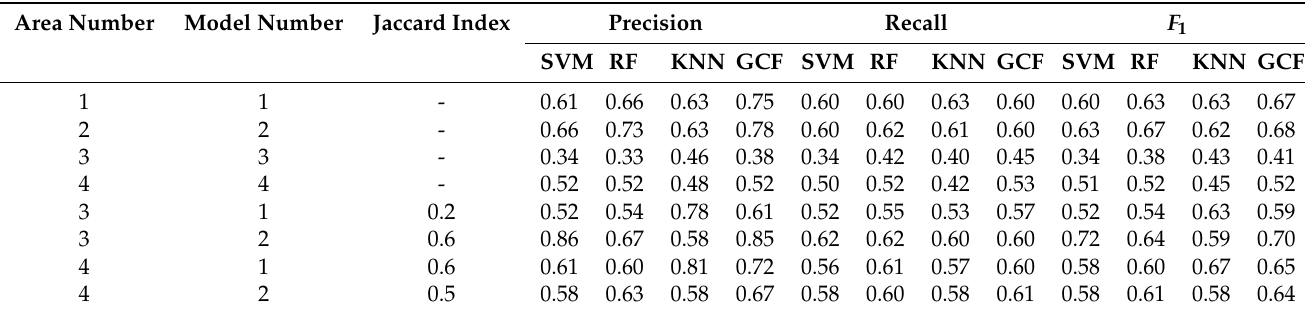
Table 2. Results of using candidate models to predict landslide in different areas, including predic- tions for regular areas and predictions for scarce areas with similar environments.